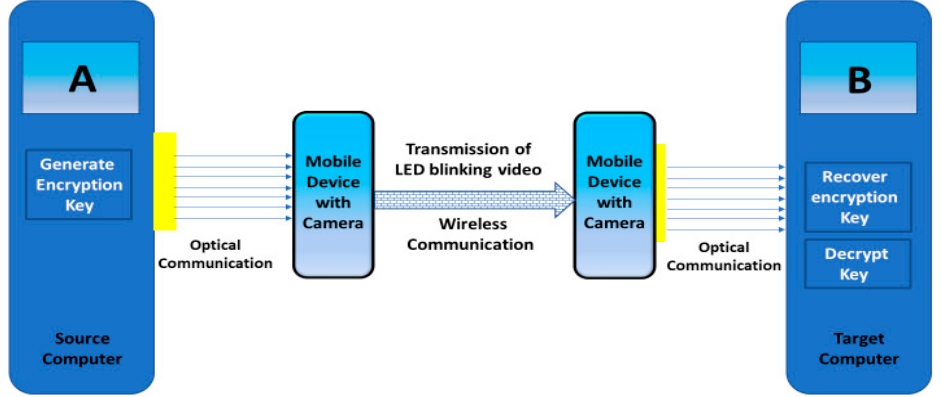
Figure 5. High level secured key transmission system.